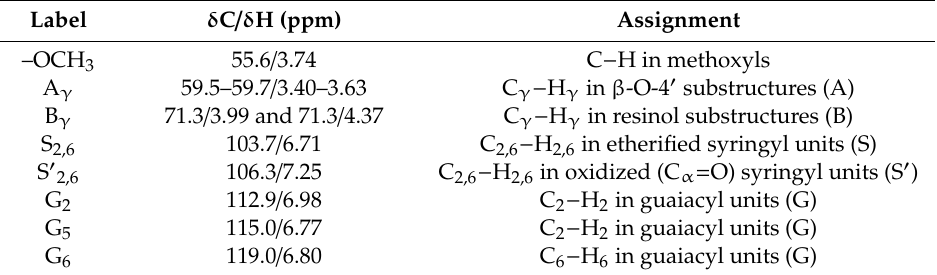
Figure 4. HSQC spectra of AL and DL samples: Signals for sidechain in ( a ) AL ( b ) HBr-DL ( c ) HI-DL and signals for aromatic ring in: ( d ) AL ( e ) HBr-DL ( f ) HI-DL. Assignments for 13 C- 1 H cross-signals provided in Table 3. Table 3. Assignments of main AL and DLs 13 C- 1 H cross-signals in the HSQC spectra.